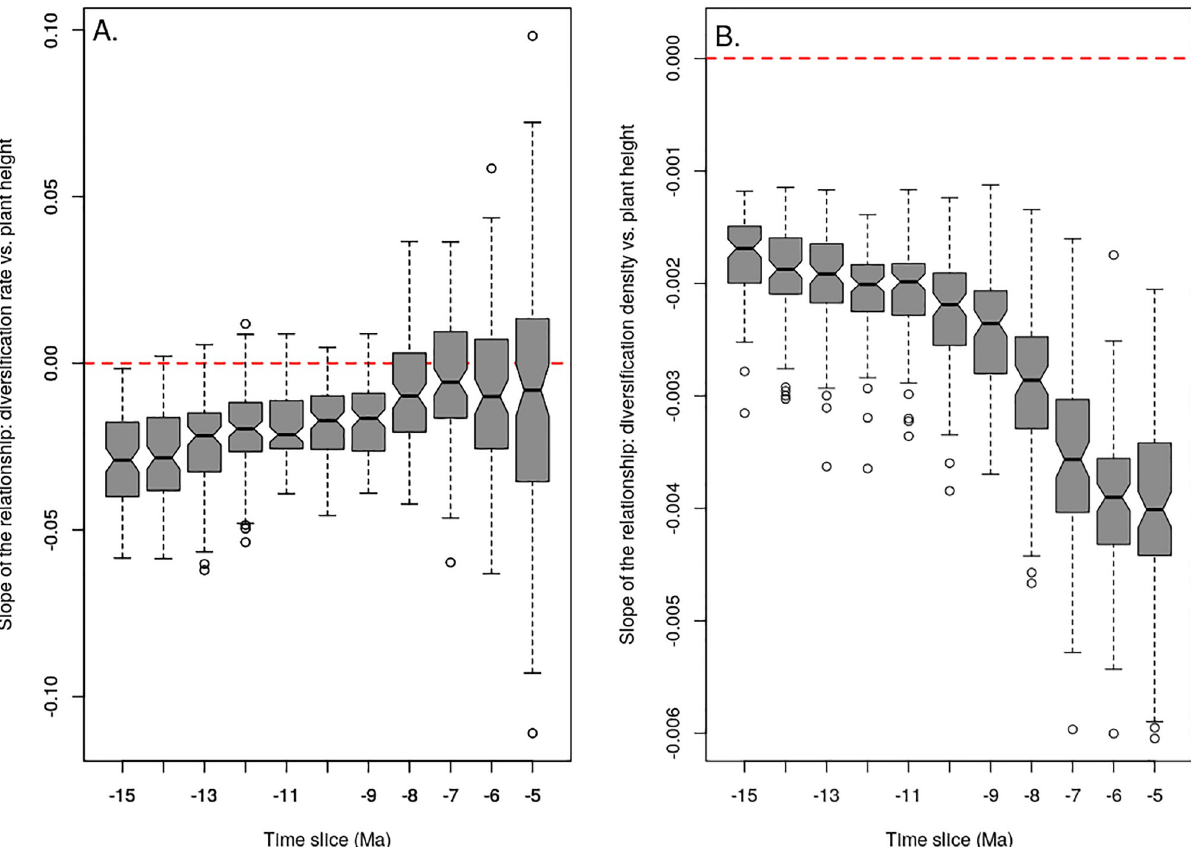
Fig 4. Influence of plant height on diversification per unit time and per unit area. In each panel, boxplots show the distribution of the slope of the relationship between one measure of diversification and median plant height in clades over the 100 posterior trees. Results for different time cut-offs are shown separately. The scale of the Y-axis varies between plots but both of them include the null slope, indicated by the dashed red line. A. Relationship between diversification rate and plant height. B. Relationship between diversification density and plant height.